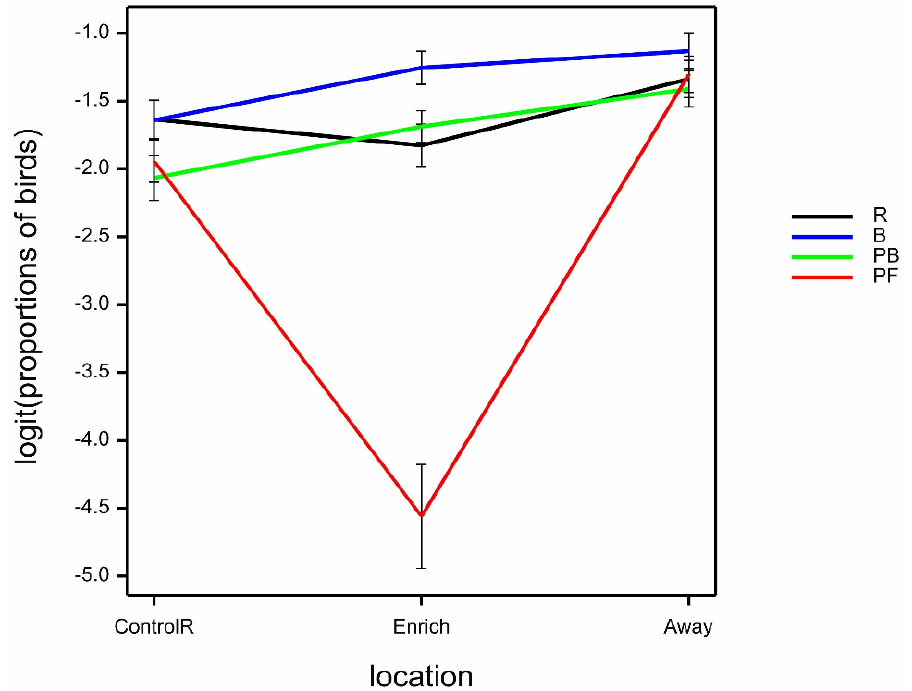
Figure 7. Mean ± SE logit (proportions of birds) observed in foraging behaviour, according to loca- tion (ControlR, Enrich, Away) and treatment (R, B, PB, PF), estimated from GLMM. (ControlR, Enrich, Away) and treatment (R, B, PB, PF), estimated from